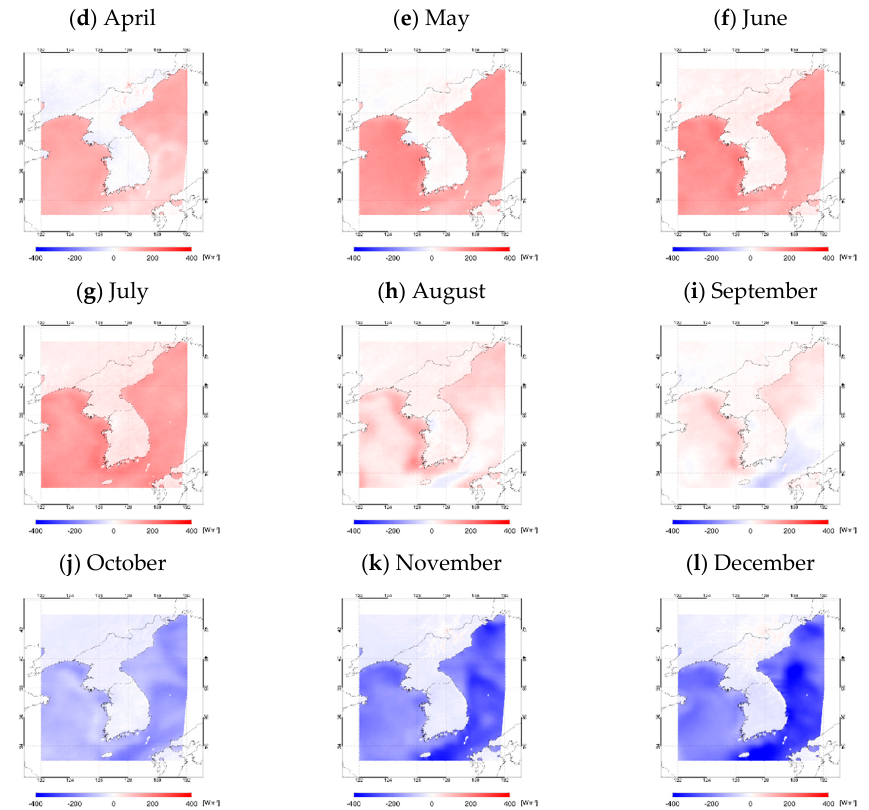
Figure 13. Distribution of monthly mean energy budget ( R S ) at the surface for the Korean Peninsula region in 2016.